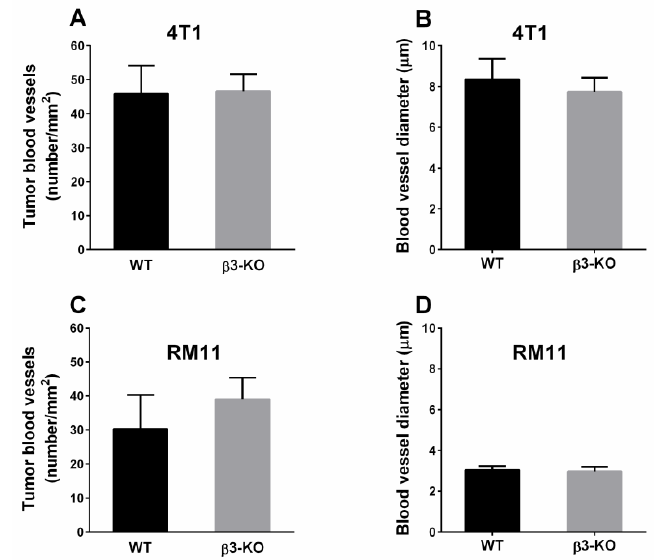
Figure 2. Microvascular density ( A , C ) and diameter ( B , D ) in orthotopic 4T1 ( n = 4 and n = 5) and subcutaneous RM11 ( n = 5) tumors were calculated using immunohistochemical detection of CD31. No statistical differences in tumor blood vessel density (4T1 p = 0.86, RM11 p = 0.14) or diameter (4T1 p = 0.36, RM11 p = 0.69) were found. Mean ± SD.